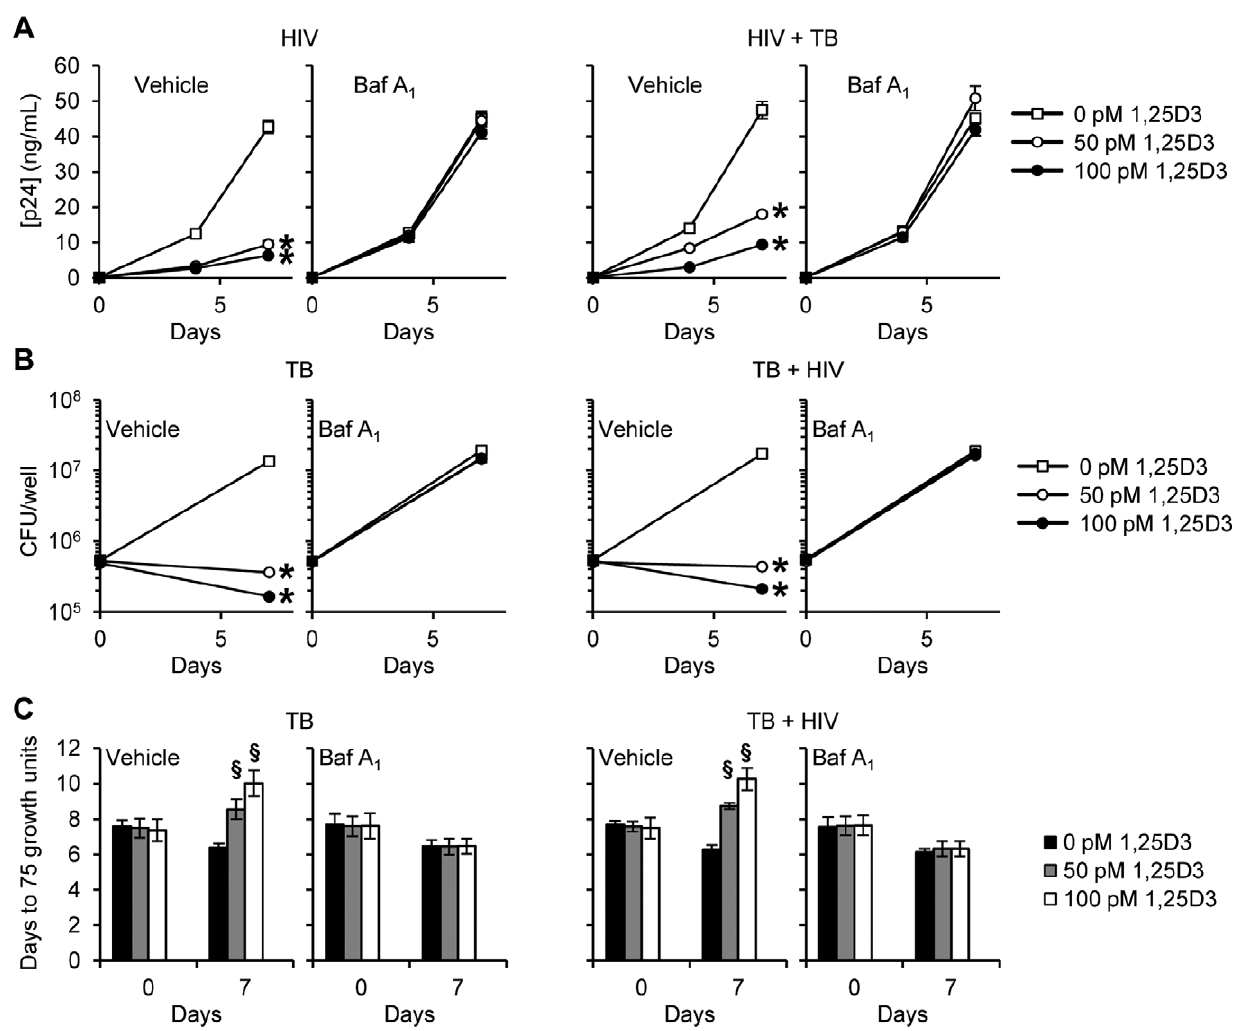
Figure 6. Bafilomycin A 1 inhibits the 1,25D3 mediated inhibition of HIV and M.tuberculosis replication. MDM were pretreated with bafilomycin A 1 (Baf A 1 ) before treatment with 1,25D3 and subsequent infection with HIV and/or M. tuberculosis (TB). (A) ELISA performed for HIV p24 antigen release at days 0, 4 and 7. (B) Intracellular mycobacteria were harvested and assayed for mycobacterial growth by cfu enumeration at day 0 and 7. (C) Intracellular mycobacteria harvested and assayed for viability using the MGIT 960 based on time to positivity at day 0 and 7. All bar and line graphs are reported as mean 6 s.e.m. of three independent experiments performed in triplicate. 1 P , 0.05; * P ,